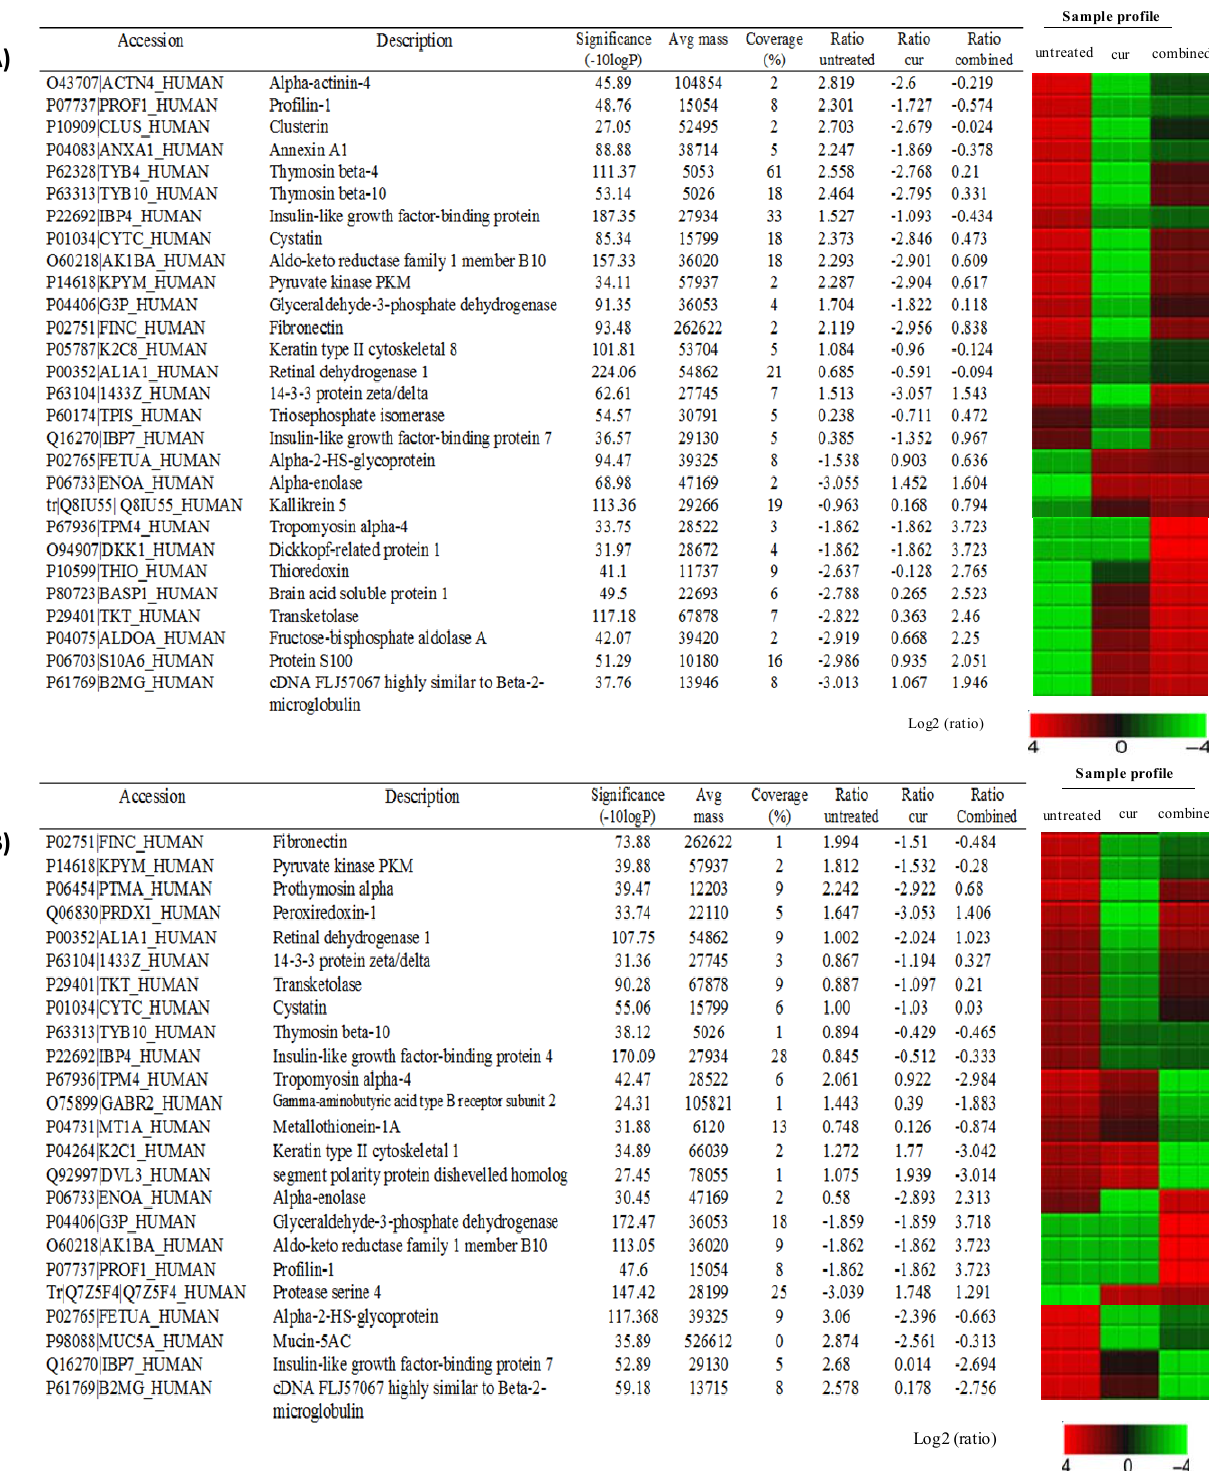
Figure 6. Expression of proteins in CD166 + EpCAM + CSCs ( A ) and CD166-EpCAM-non-CSCs ( B ) subpopulations of A549 cell following treatments with curcumin and in combination with cisplatin as compared to the untreated group. The sample profile in all 12 samples are colour-coded and range from − 4 to 4 log.